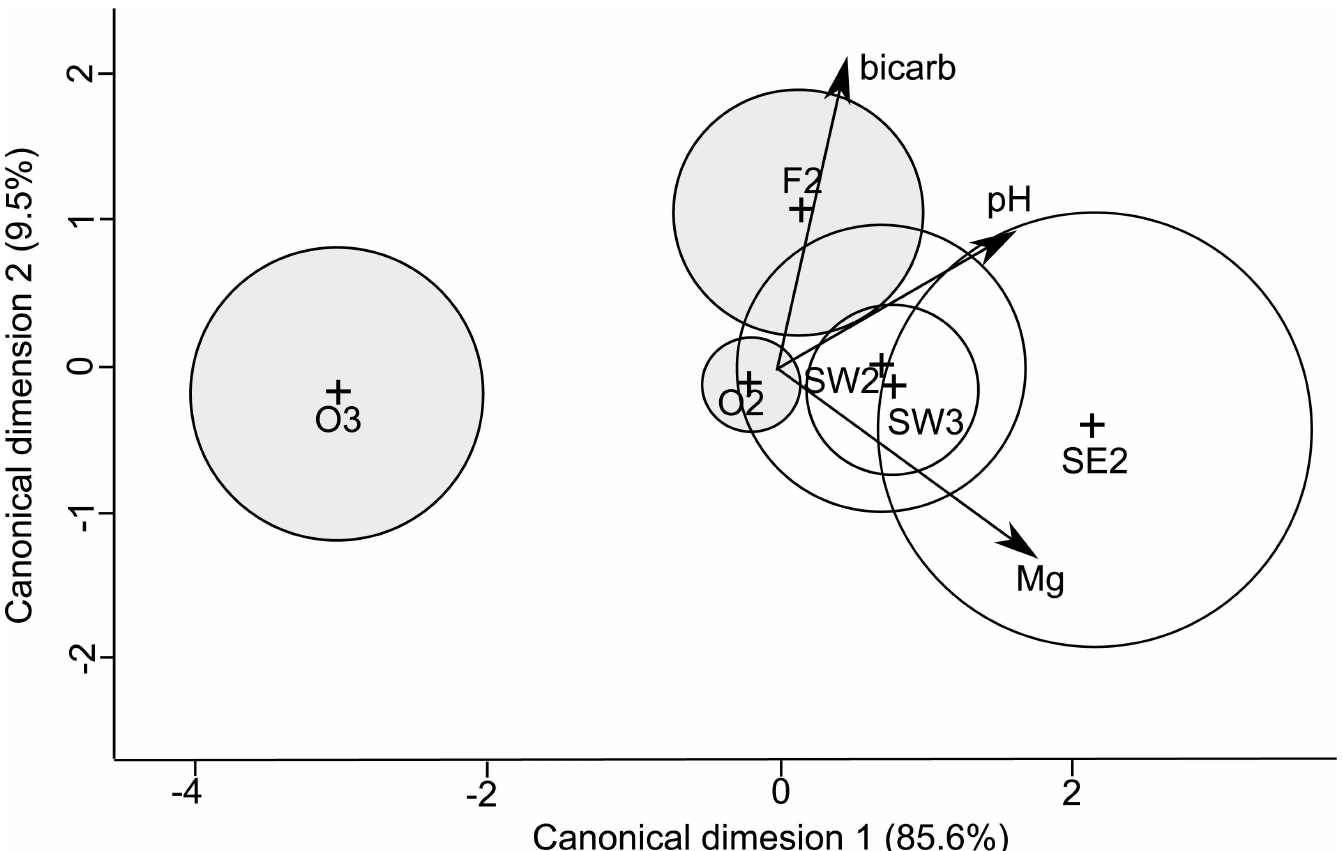
Fig 5. The centroid means for each of the sites plotted in the first two canonical discriminant dimensions. The direction and length of the vectors show the strength and nature of the correlation with each variableand the canonicaldiscriminant axes. The percent values for each axes is the percentage of variabilityamong the centroidmeans explainedby each of the two axes. Grey circles represent sites with red shallowwater lobsters, whilewhite circles represent sites with brindledeep water